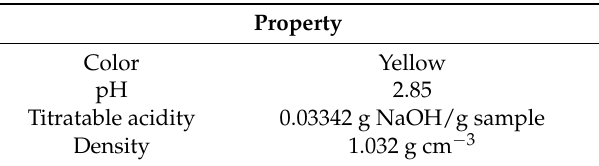
Table 3. Properties of GG100 PA after